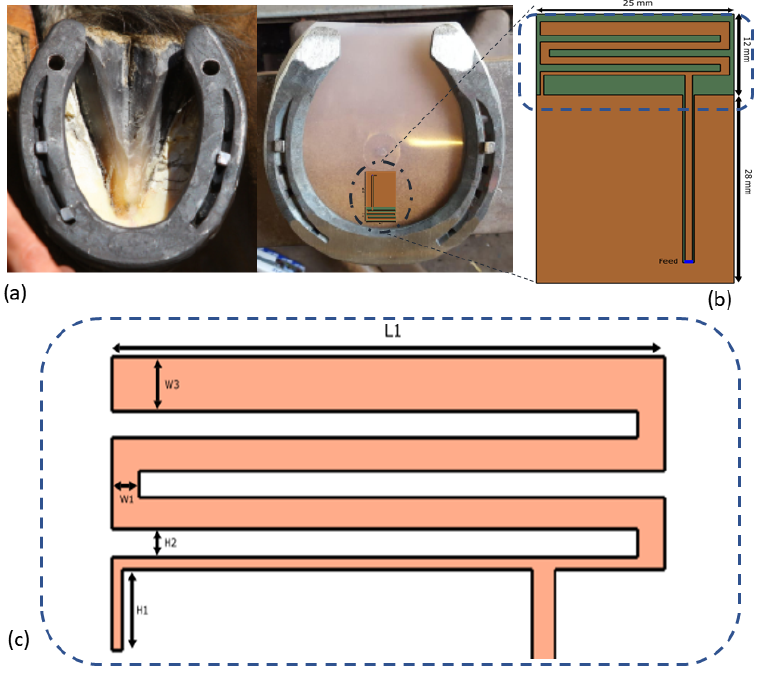
Figure 1. ( a ) An example of a horse hoof and a horse hoof with the planar pad with the embedded electronics: ( b , c ) design of the planar IFA antenna; the dimensions in ( b , c ) design of the planar IFA antenna. The dimensions in ( b ) are WT = 25 mm, LT1 = 12 mm, and LT2 = 28 mm; in ( c ) they are H1 = 3 mm, H2 = 1 mm, W1= 1.2 mm, W3 = 2 mm, and L1 = 25 mm, and the width of the short strip is 0.5 mm. The meandering arm continues with this thickness until the first corner after the feedline, thereafter it changes to W1 until the last corner to W3. The gaps between the meandering lines are all H2. The distance between the shorting pin and feed is 18